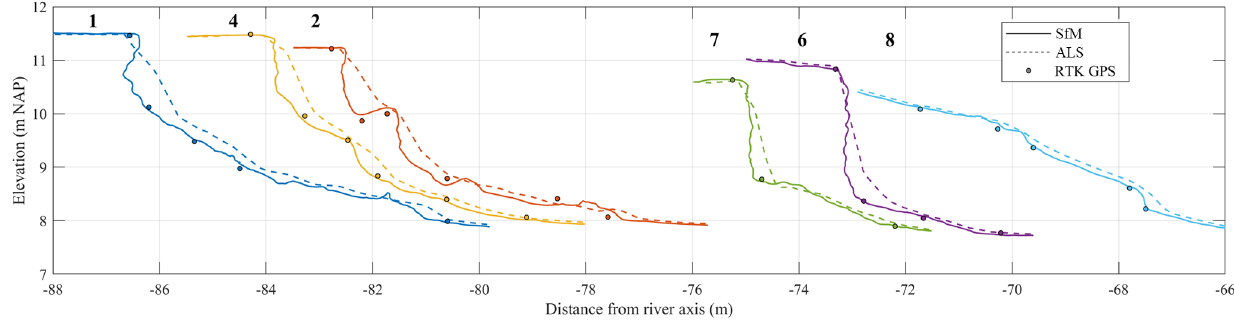
Figure 11. Banks measured with SfM (continuous lines), ALS (dashed lines), and GPS (circles) on 17–18 January 2017. Cross-sections are located, from left to right, at river kilometres 153.4, 153.9, 153.5, 154.2, 154.1, and 154.3 (see Fig. 4 for locations).